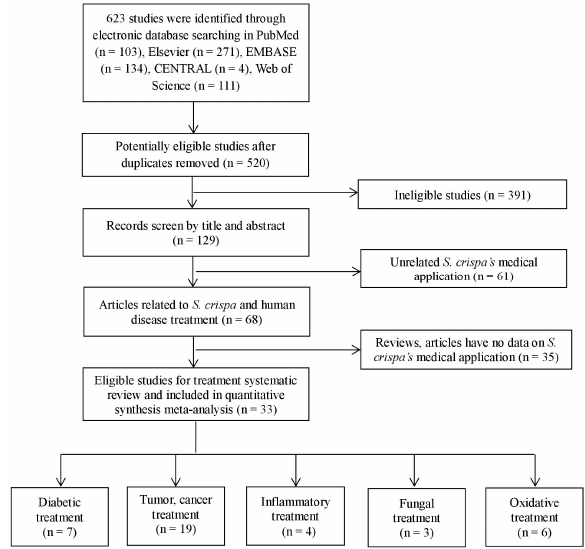
Figure 1. Systematic screening stages of the literature review.